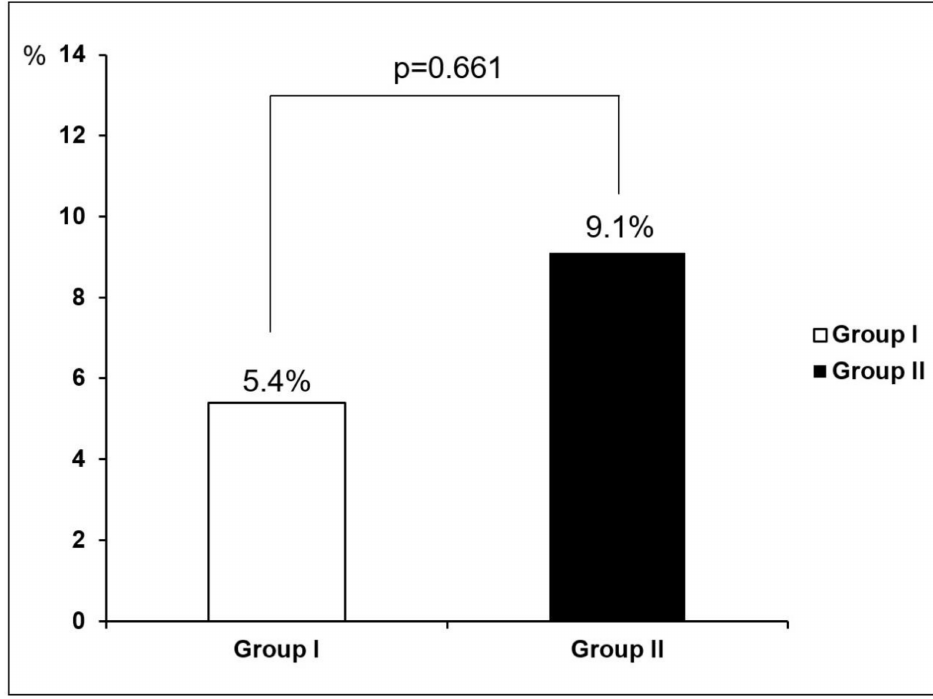
Figure 2. Primary endpoint: CIN